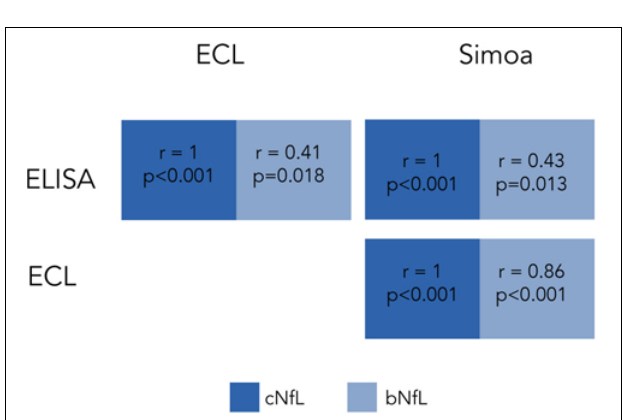
FIGURE 2 | Correlation of cNfL and bNfL across different technologies as reported by Kuhle et al. (2016a). Correlation coefficients of cNfl and bNfL levels across ELISA, ECL and